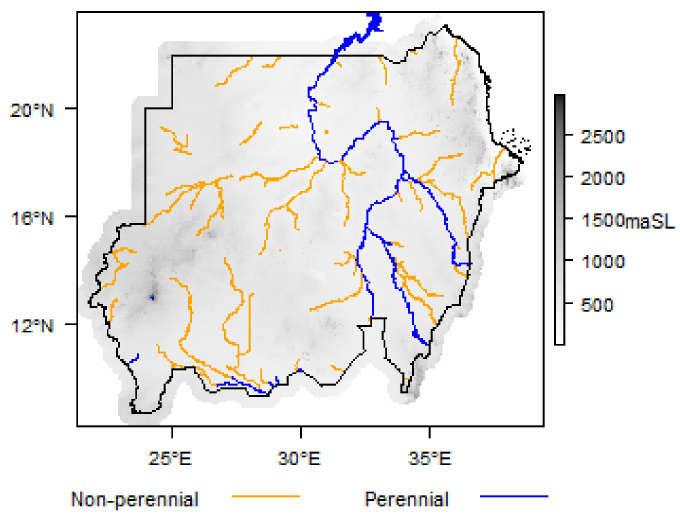
Figure 5. Hydrogeology of Sudan [18].